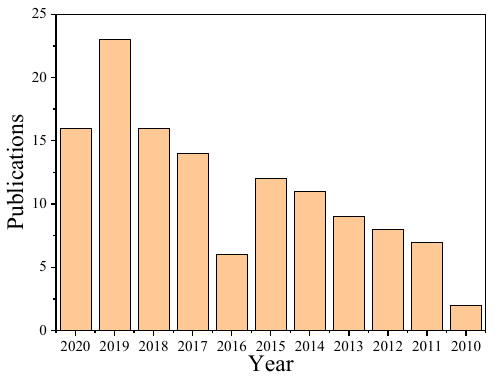
Figure 1. The publications per year of antibacterial polymer vesicles from 2010 to 2020 downloaded from Web of Science, searching with antibacterial and polymer vesicle as key words.